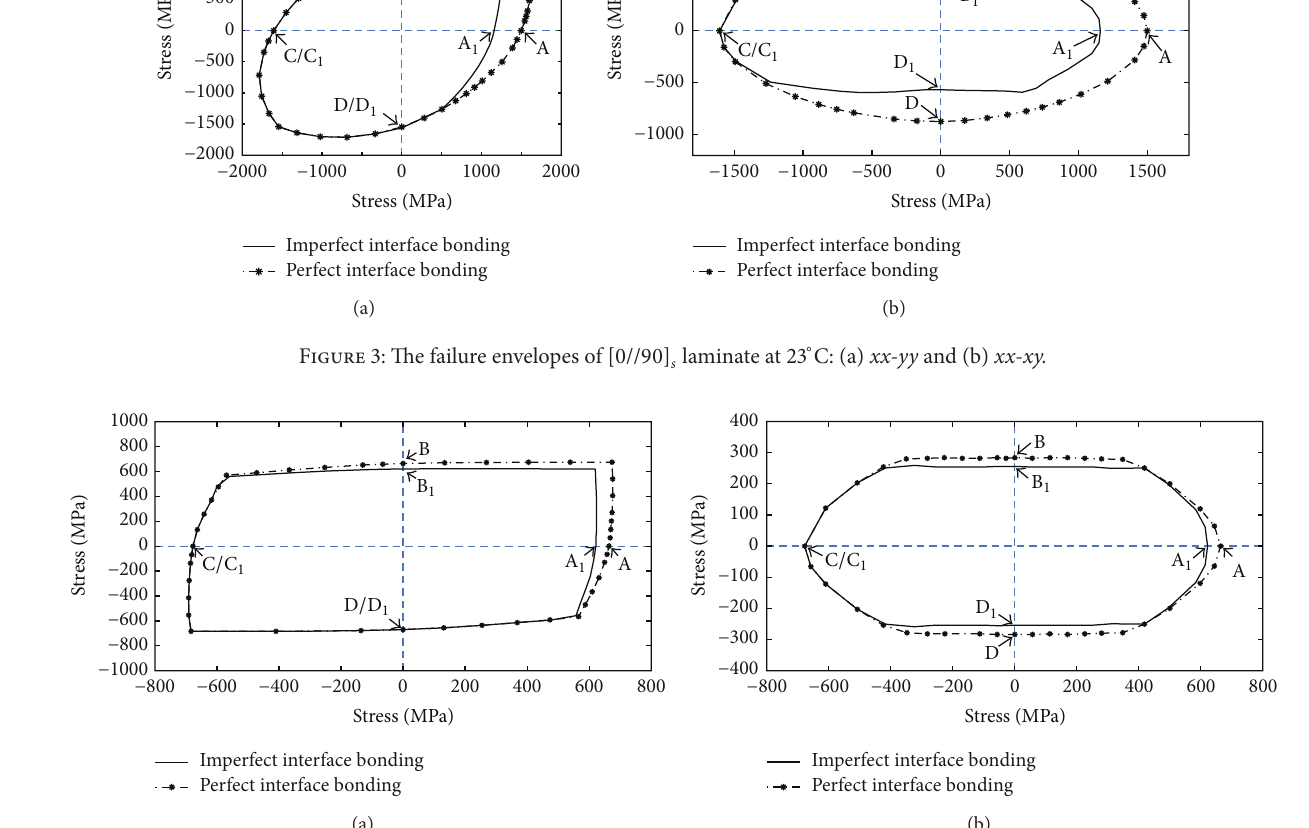
laminate at 650 ∘ C: (a) xx-yy and (b) s